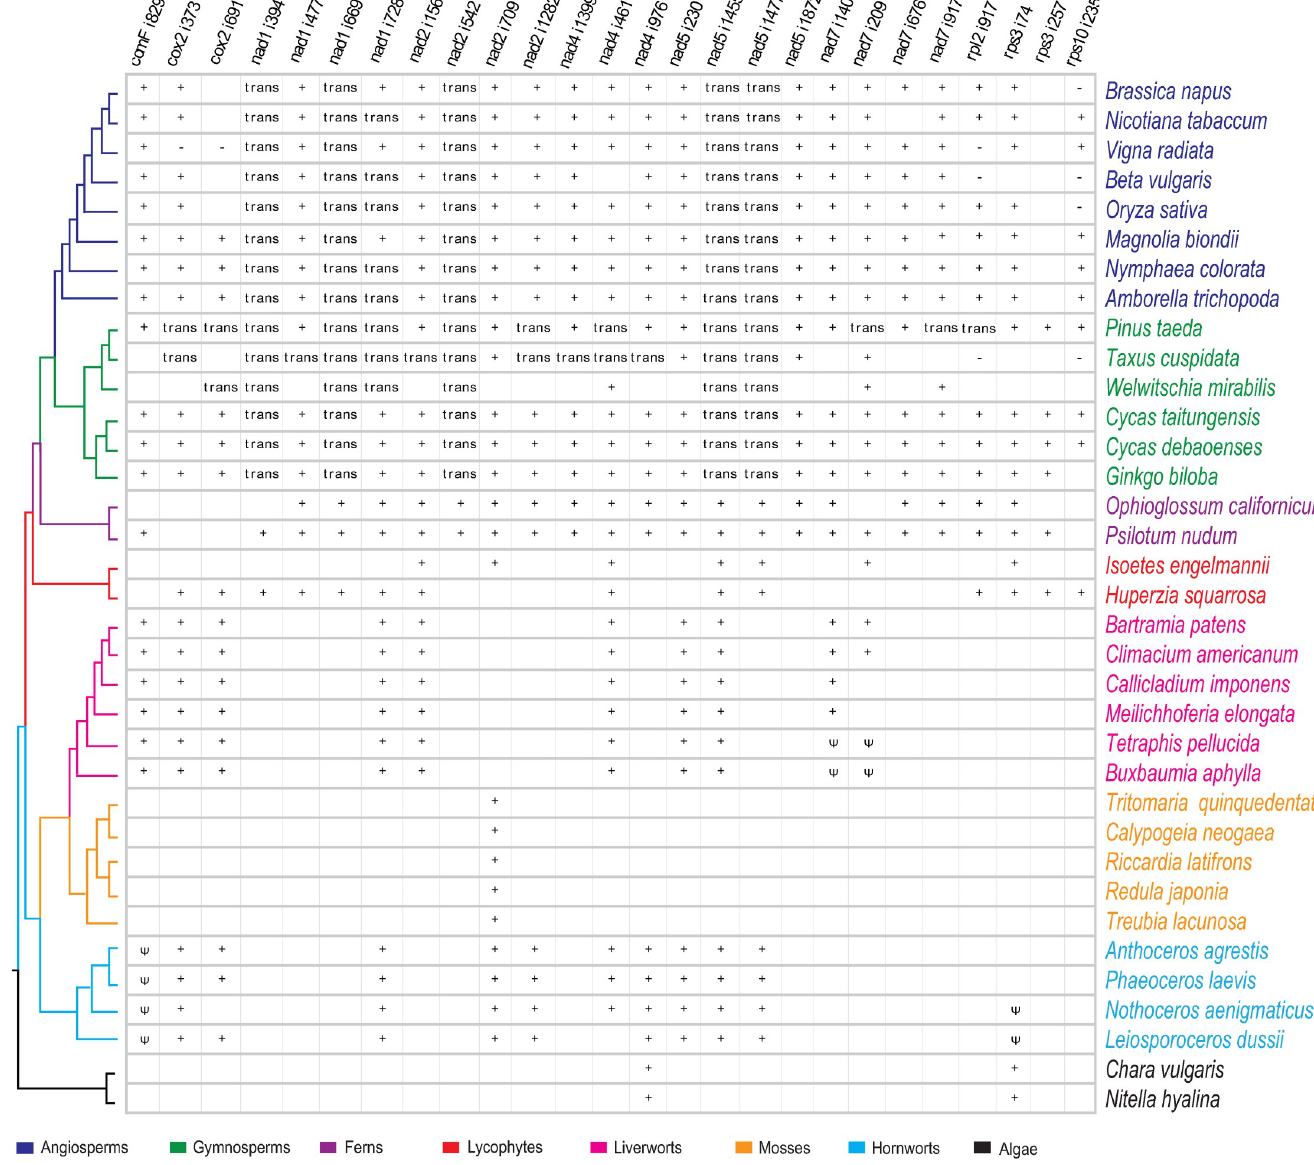
Fig 2. Distribution pattern of 26 ancestral seed plant introns among land plants. +, trans ,—and C indicates presence of an intron, trans-splicing intron, missing gene and pseudogenization, respectively. Phylogenetic tree is inferred from 1KP project [38].